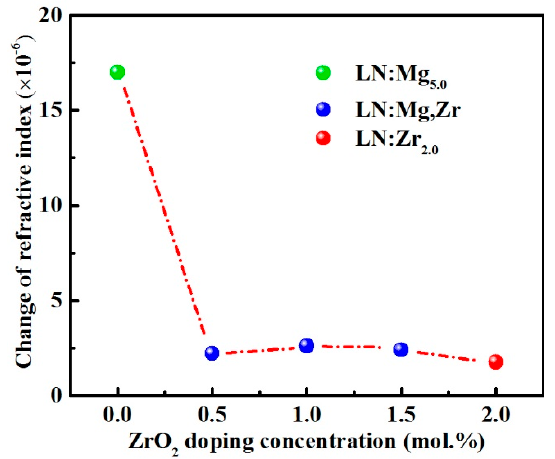
Figure 2. Refractive index changes of LN:Mg,Zr crystals as a function of ZrO 2 doping concentration. That of LN:Zr 2.0 is labelled for comparison.